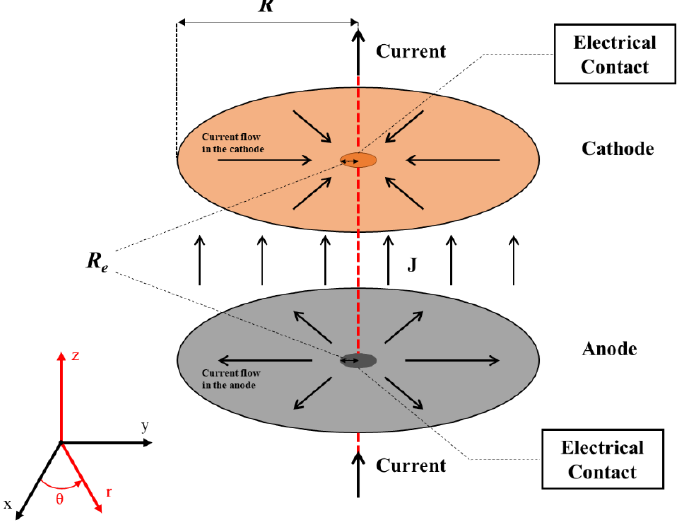
Figure 1. Schematic diagram of current flows in two parallel electrodes.